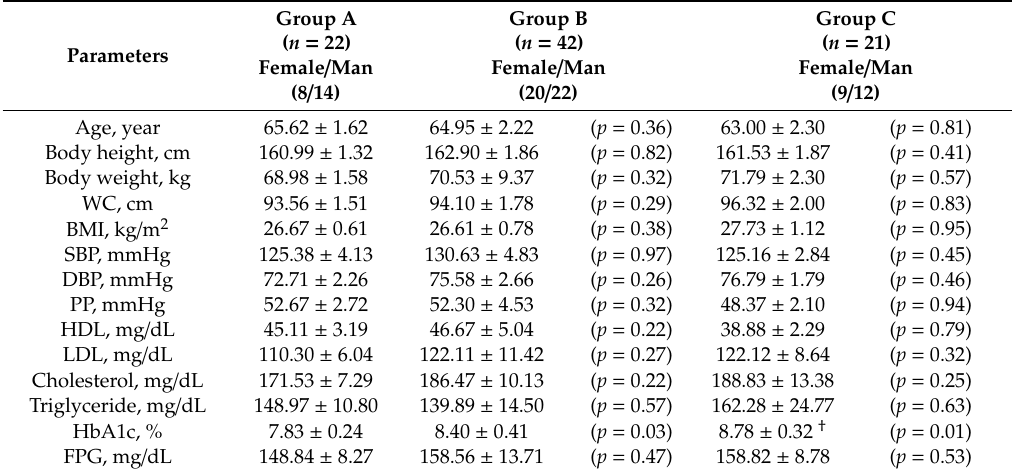
Table 3. Demographic, anthropometric, hemodynamic, and serum biochemical parameters of the testing diabetic patients in Groups 2 and 3.